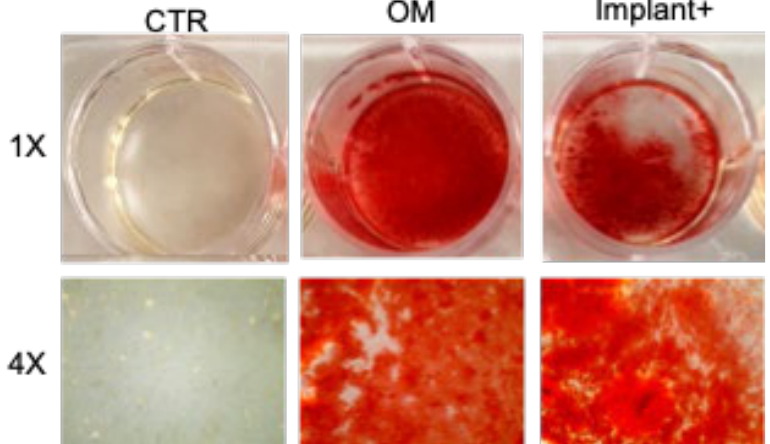
Figure 4. Osteogenic effect of the CGF-permeated implants. Alizarin Red staining of hBMSC cul- tured in basal medium (BM) (control, CTR), osteogenic medium (OM), and BM + BGP + AA + CGF- permeated implant (Implant+), for 21 days.